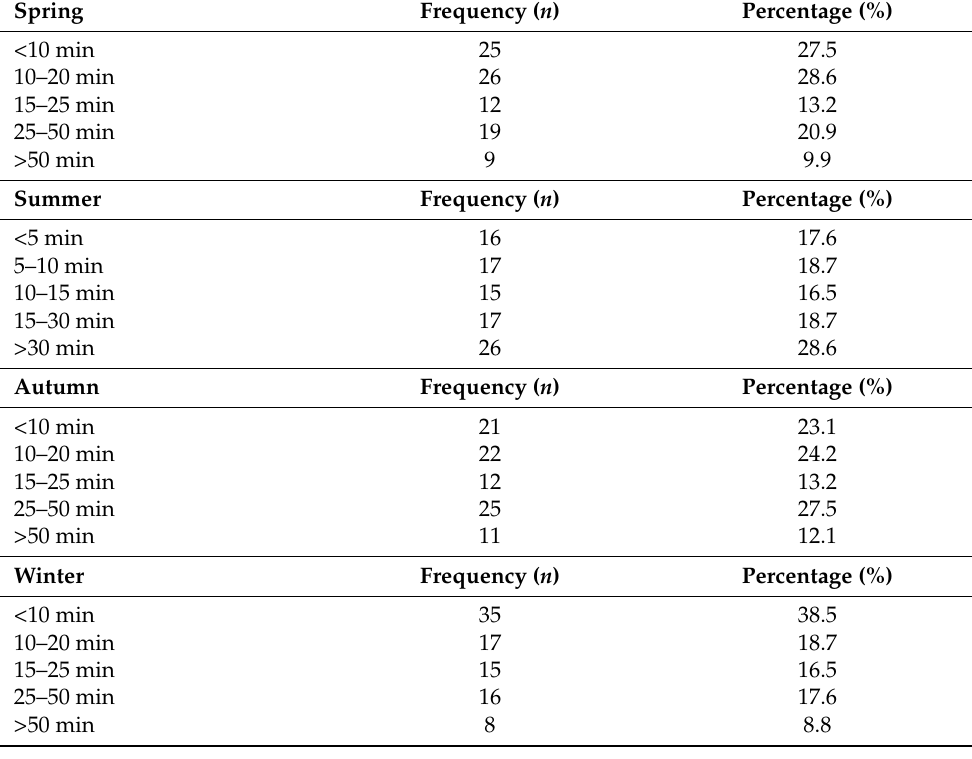
Table 4. Daily sun exposure. The specified values in the table refer to the recommendations of the German Society of Nutrition e.V. (https://www.dge.de/wissenschaft/faqs/vitamin-d/, accessed on